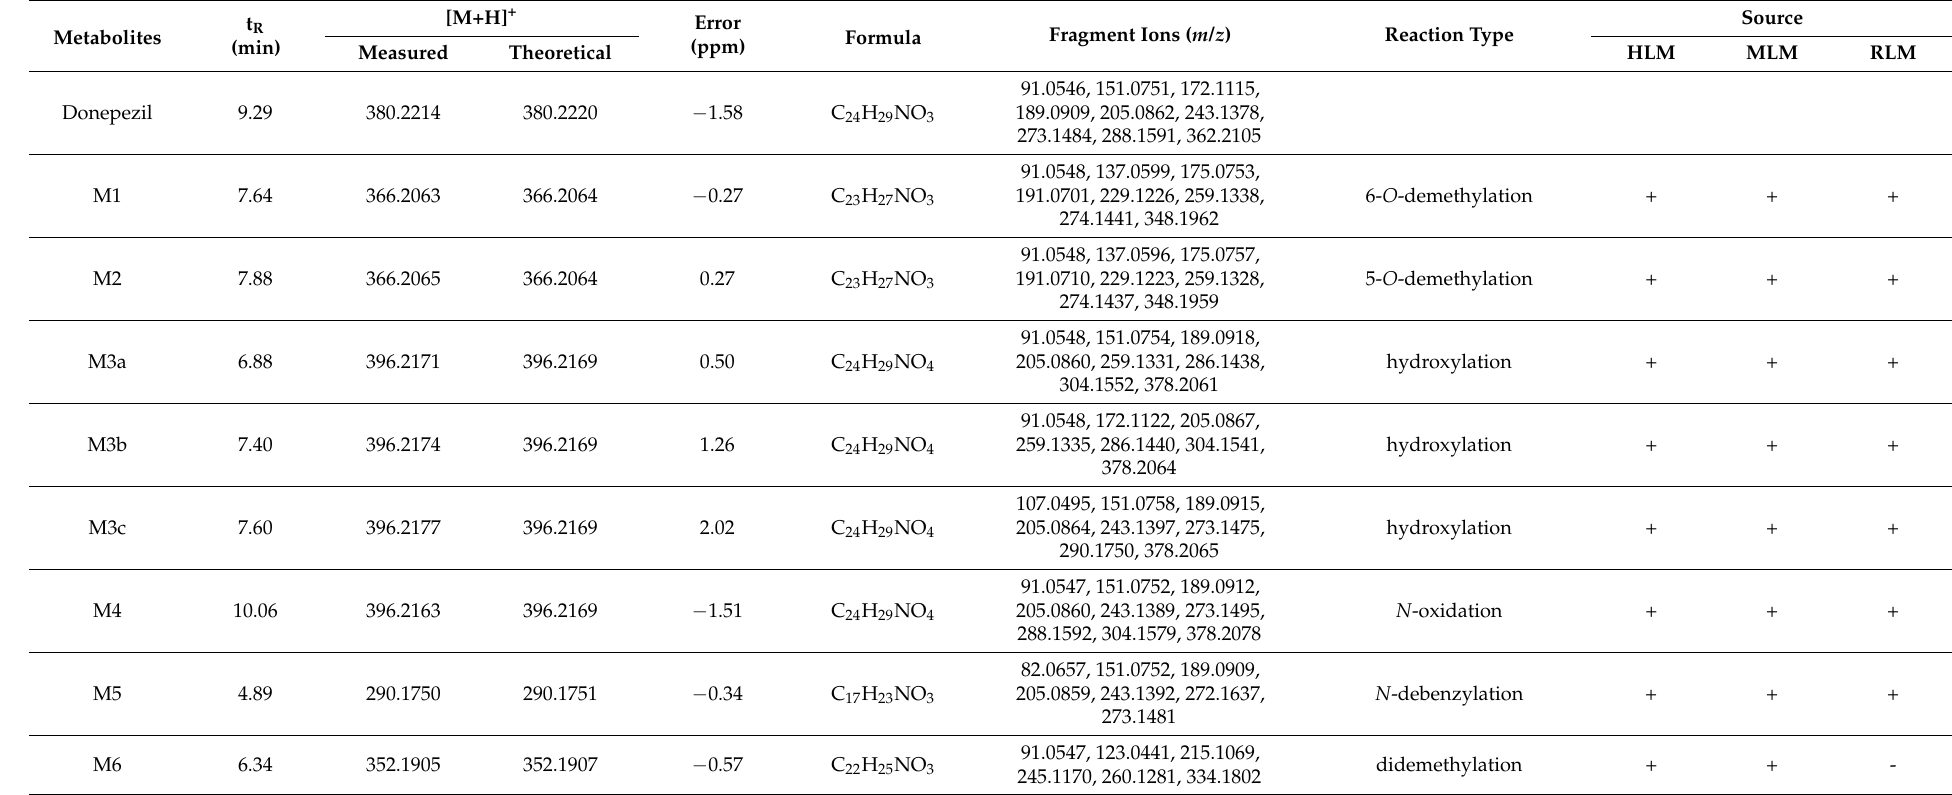
Table 1. Summary of donepezil metabolites produced through in vitro metabolism by liver